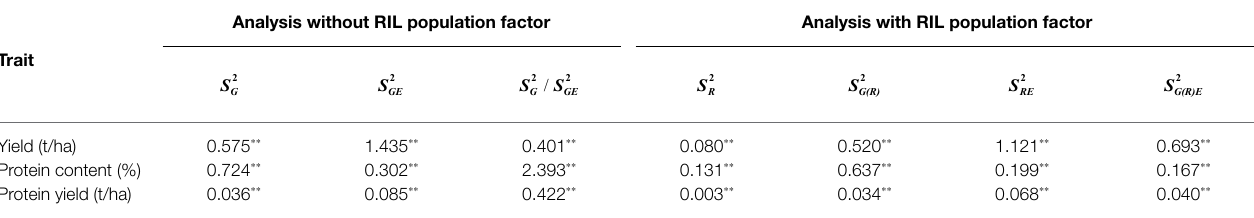
), genotype × environment interaction ( 2 G S